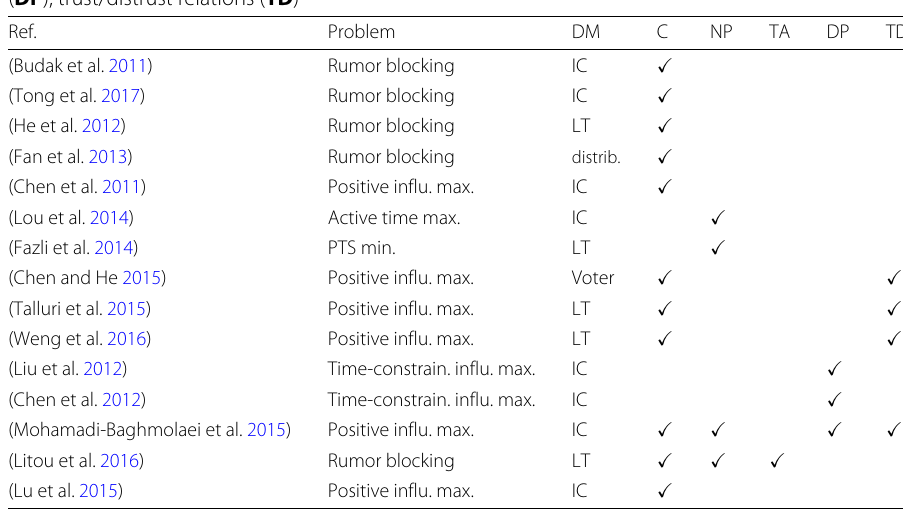
Table 1 Summary of related work based on optimization problem, basic diffusion model ( DM ), competitive diffusion ( C ), non-progressivity ( NP ), time-aware activation ( TA ), delayed propagation ( DP ), trust/distrust relations ( TD )